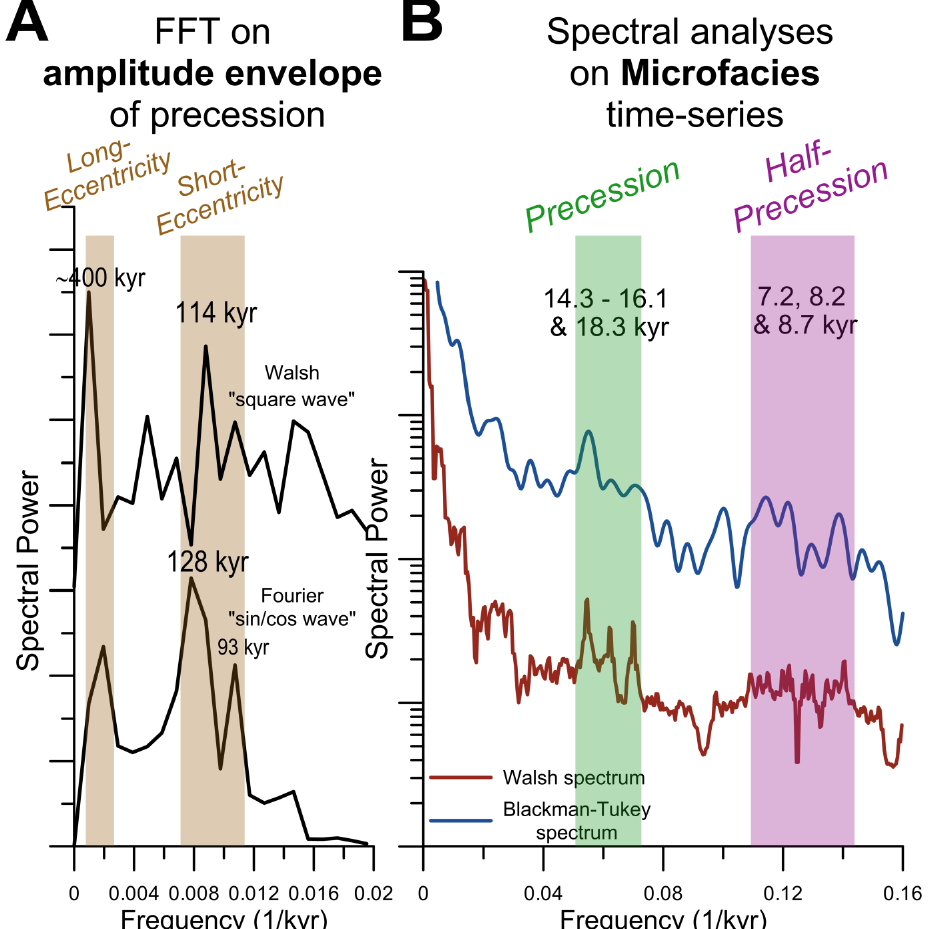
Fig. 7. Spectral analyses on the microfacies series of the “La Couvinoise” section as a whole. (A) : FFT periodogram of the amplitude envelope of the precessional signal. Upper: based on Walsh Transform (Fig. 6b); Lower: based on Fourier Transform (Fig. 6c). A linear “spectral power” axis is chosen to give an immediate sense of how much of the variance comes from each cycle. (B) : MTM power spectrum of the “La Couvinoise” microfacies curve as a time-series. A logarithmic “spectral power” axis is chosen to make the statistical significance of peaks evident, particularly for small high-frequency peaks. CL=Confidence Limit.